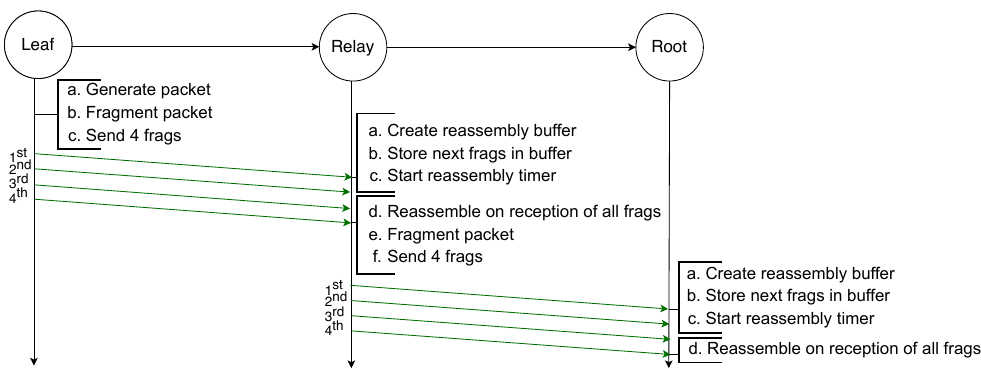
Figure 2. Successful transmission of a fragmented packet with standard 6LoWPAN over two hops.